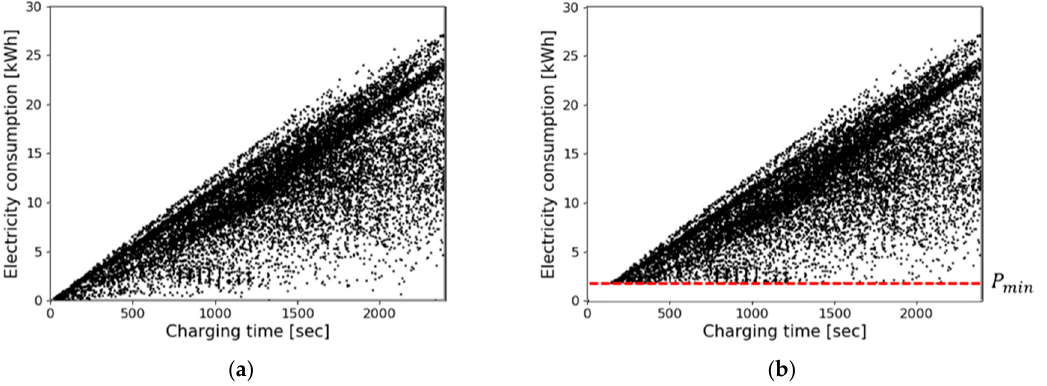
Figure 4. A proposed technique considering the minimum electricity consumption. Data with a lower electricity consumption value based on the minimum electricity consumption value defined by Pmin is removed. Graphs ( a ) before applying the proposed method and ( b ) after applying the proposed method.